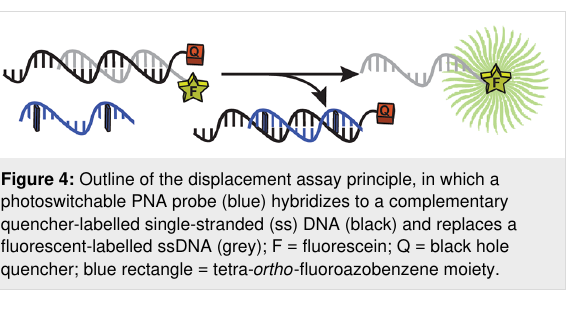
After optimization, we found the following conditions: 0.75 μ M quenched double-stranded (ds) DNA, 2 equiv PNA for 8